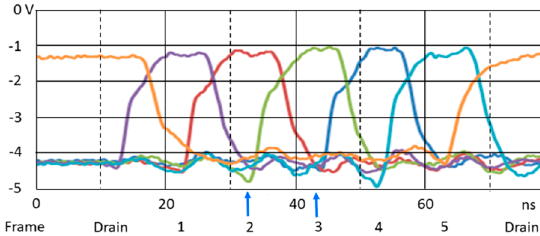
Figure 6. Driving pulses for the drain gate and the collection gates 1 to 5 ( ∆ t = 10 ns). The blue arrows show the times of the LD images in the second and the third rows in Figure 5, and those in the first and the sixth rows in Figure 7.